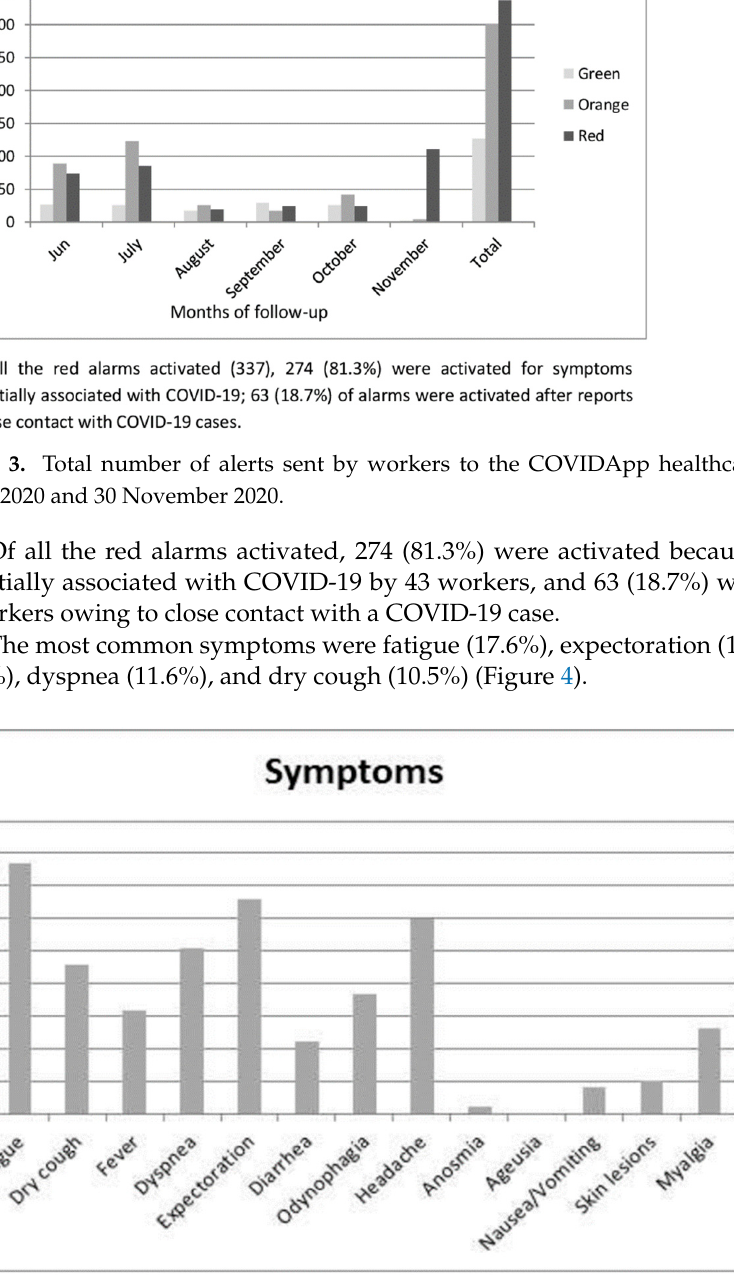
Figure 2. Number of workers who completed the questionnaire (total), number of these workers who reported signs and/or symptoms related to COVID-19 (symptomatic), and number of work-